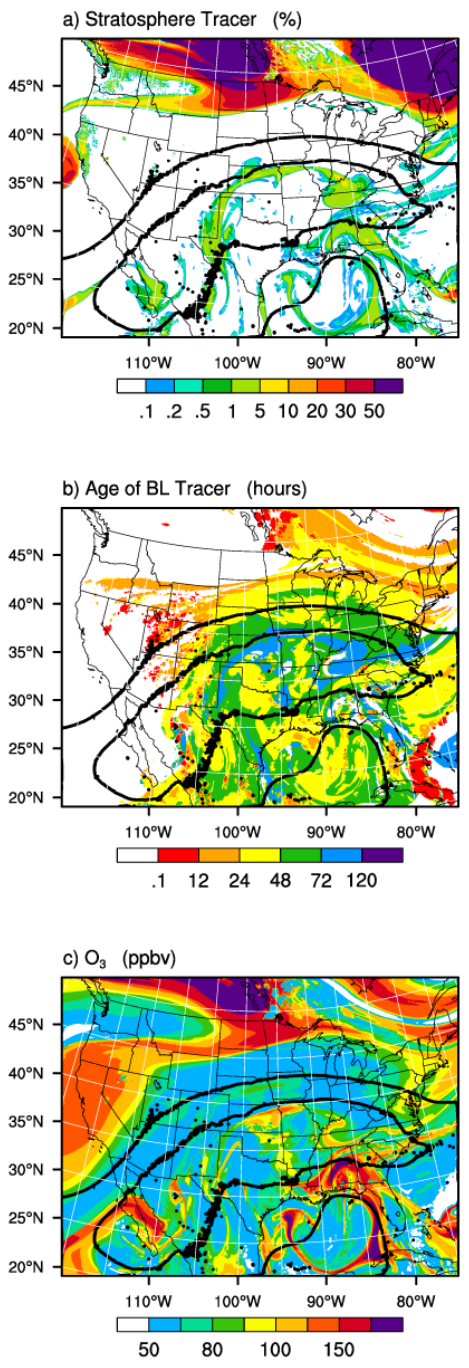
Fig. 15. WRF-Chem simulated (a) decaying stratosphere tracer (%), (b) age of the boundary layer tracer (hours), and (c) O 3 mixing ratio (ppbv) at 250hPa for 21:00UTC 5 August 2006. Contour levels for O 3 are 50, 70, 80, 90, 100, 120, 150, and 200ppbv. Overlaid is geopotential height at 300hPa for z = 9680m and 9730m, which defines the anticyclone in the